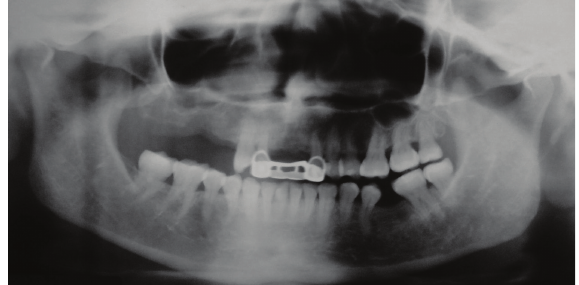
Figure 4: Panoramic X-ray shows a complete postoperative view without the foreign